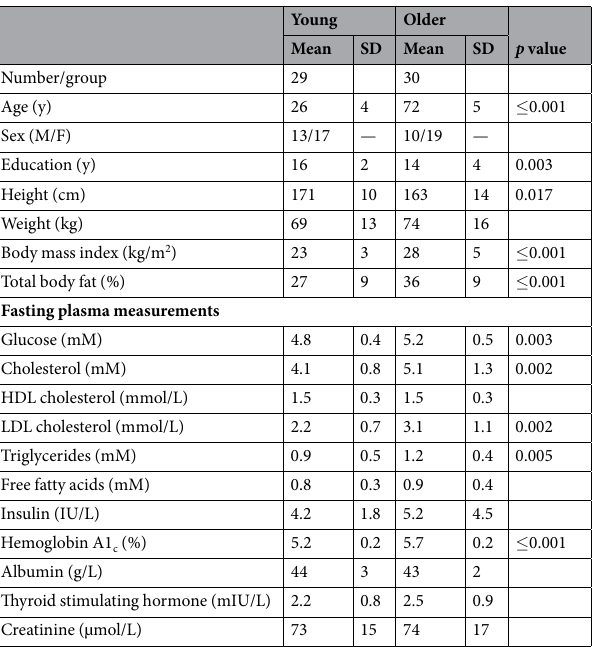
Table 2. Characteristics of study participants. P -values were calculated using unpaired t -tests and a chi-square test was used to evaluate sex differences between the two groups, uncorrected for multiple comparisons, * p ≤